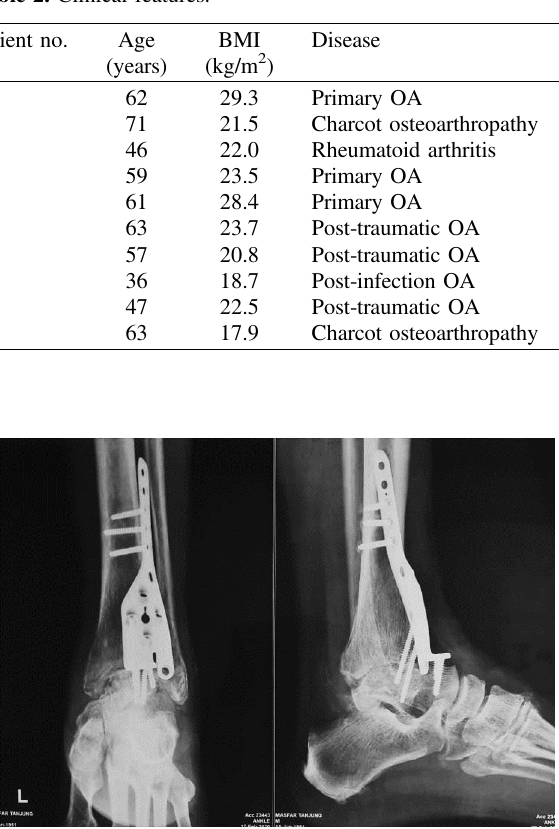
Table 2. Clinical features.